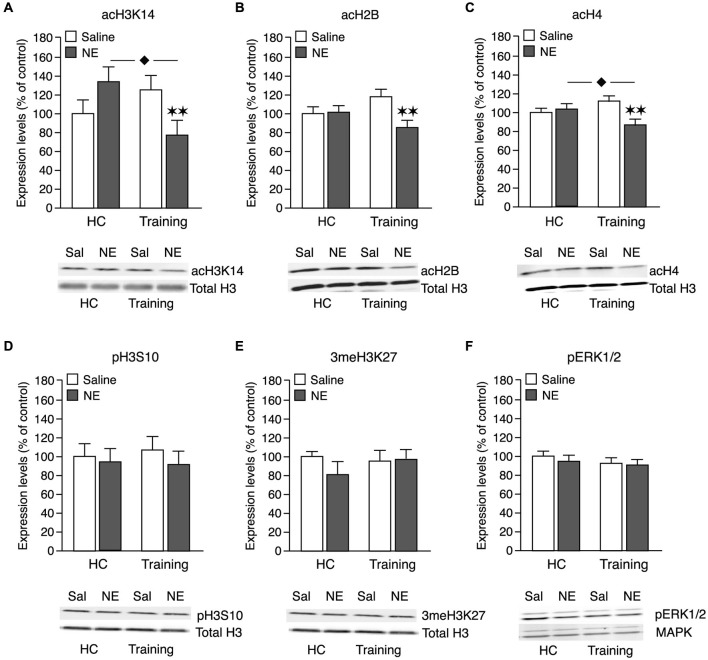
Effect of a memory-enhancing dose of norepinephrine administered into the BLA on histone PTMs and pERK1/2 activity in the IC. Rats were trained on an object recognition task for 3 min and given posttraining bilateral infusions of a memory-enhancing dose of norepinephrine (NE; 1.0 μg in 0.2 μl) or saline (Sal) control into the BLA. Other groups of rats received the same dose of norepinephrine or saline into the BLA without training (home cage; HC). Tissue was collected 1 h after training and drug administration and histones were prepared from punches taken from the IC. Histone PTMs were revealed by immunoblotting and normalized to total histone H3 levels on the same blot. Histone PTMs (mean ± SEM) are shown as percentage of the saline-treated home cage control group. Quantification of acH3K14 (A, Sal-HC: n = 13; NE-HC: n = 10; Sal-Training: n = 10; NE-Training: n = 11), acH2B (B, Sal-HC: n = 13; NE-HC: n = 10; Sal-Training: n = 10; NE-Training: n = 11), acH4 (C, Sal-HC: n = 13; NE-HC: n = 11; Sal-Training: n = 10; NE-Training: n = 11), pH3S10 (D, Sal-HC: n = 13; NE-HC: n = 11; Sal-Training: n = 10; NE-Training: n = 12) and 3meH3K27 (E, Sal-HC: n = 12; NE-HC: n = 11; Sal-Training: n = 11; NE-Training: n = 11) levels in home cage controls and trained rats. Levels of total H3 remained unchanged in the different experimental conditions. (F) Cytoplasmic fractions of the IC were prepared for pERK1/2 assessment. pERK1/2 was revealed by immunoblotting and normalized to total MAPK levels. Sal-HC: n = 13; NE-HC: n = 9; Sal-Training: n = 11; NE-Training: n = 12. **p < 0.01 vs. the trained saline group. ⧫
p < 0.05 vs. the non-trained norepinephrine group.